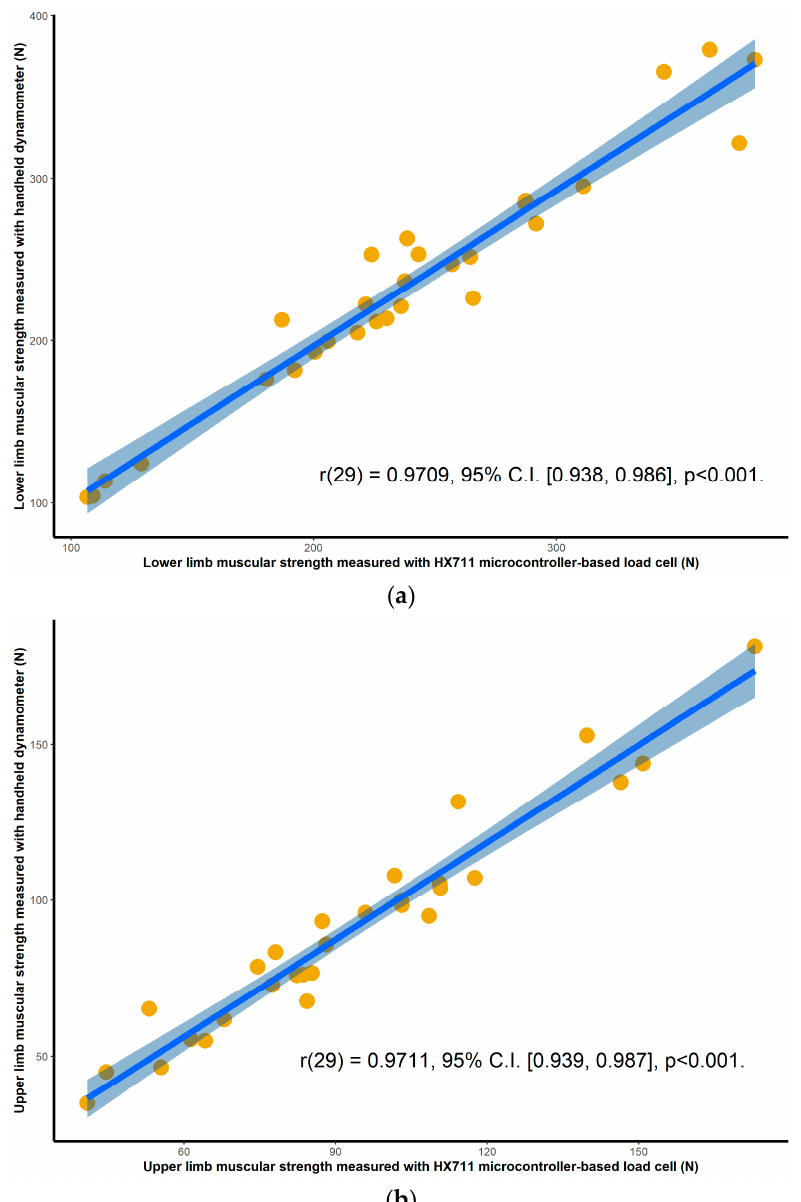
Figure 2. Session one correlations between the handheld dynamometer and the HX711 microcontroller-based load cell for: ( a ) maximal isometric leg extension; ( b ) maximal isometric bicep flexion. The blue line and the shaded area are the linear regression slope and its 95% confidence region.